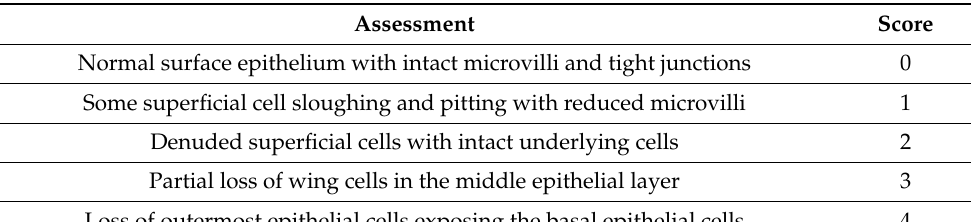
Table 4. Semi-quantitative system grades of the histopathological appearance of the corneal epithelium.